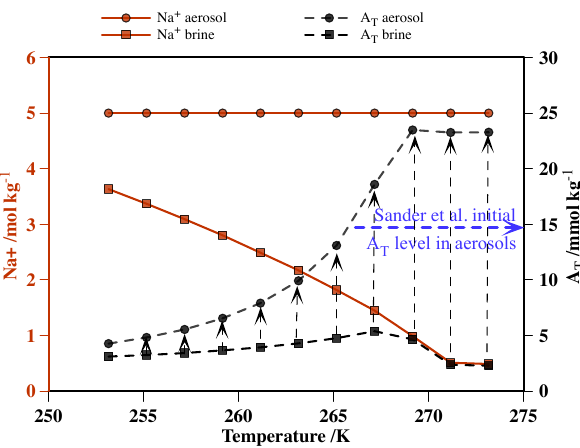
Fig. 3. A T (black, dashed) and Na + (red, solid) molalities in brine (squares, “cryoconcentrated”) and in aerosols (circles, “evapocon- centrated”) as a function of temperature. A Na + molality of 5 mol kg − 1 was used. The “evapoconcentration” curve for A T can be directly compared to the A T value chosen by Sander et al. (2006) to initialize their model runs in the case where carbonate precipita- tion is allowed, which is presented in blue. Vertical dashed arrows illustrate A T evapoconcentration pathways.